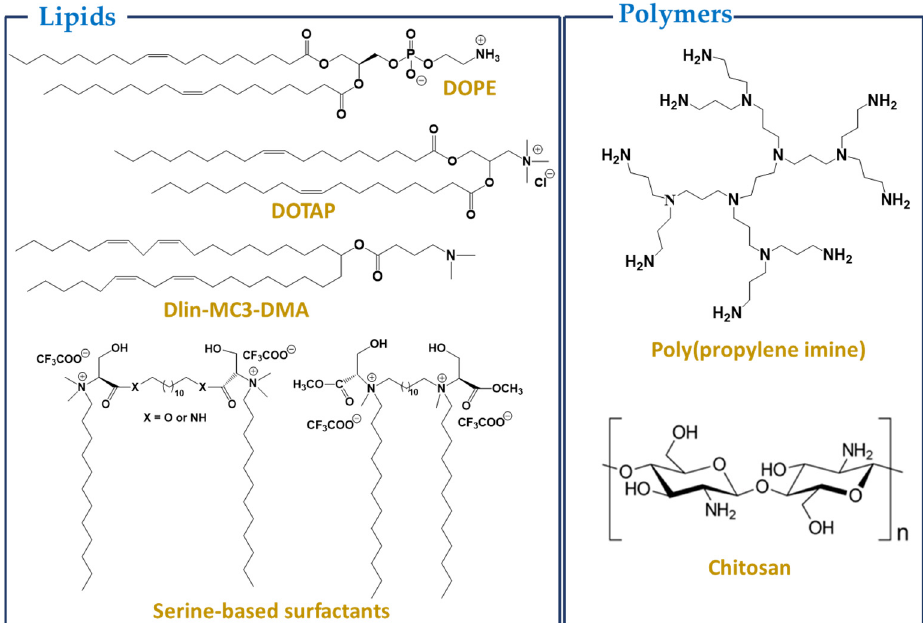
Figure 3 . Structures of some c ommon lipids/polymers used for preparing nanoparticles. Figure 3. Structures of some common lipids/polymers used for preparing